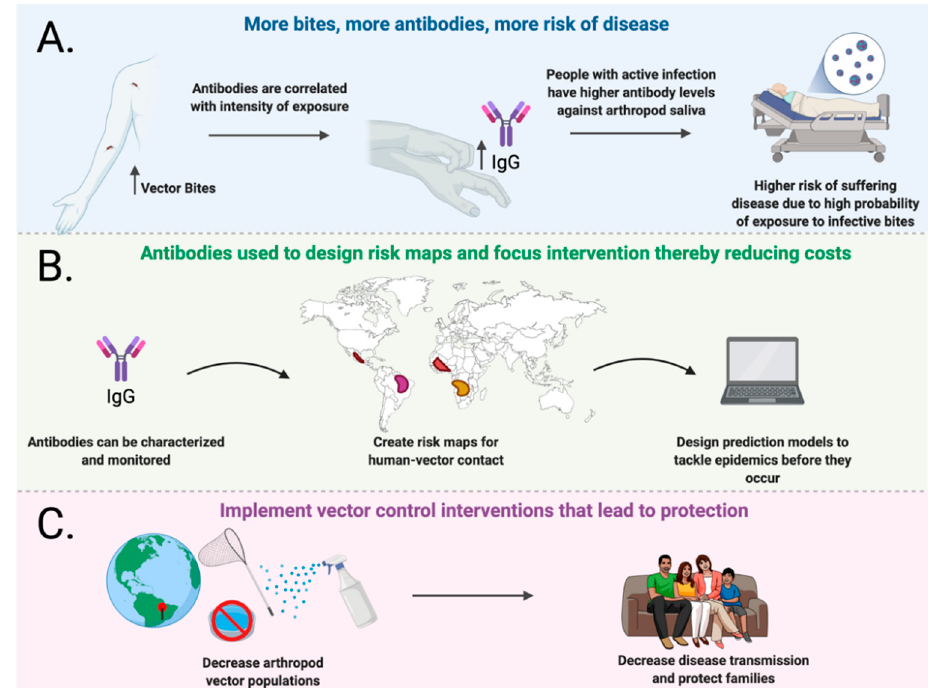
Figure 2. Use of antibodies against salivary proteins for epidemiological purposes. ( A ) Higher antibodies against specific vector salivary proteins are found in people exposed to bites and presenting disease. ( B ) These antibody levels can be used to design risk maps and to identify vector-human-contact “hot spots” within a community. With the proper model, changes in antibody levels can be used to predict epidemics before they occur. ( C ) The identification of “hot spots” may reduce intervention cost by directing efforts to areas where more human contact rates are observed protecting the entire community (figure created with BioRender.com and MindtheGraph.com) (accessed on 4 March 2021) .